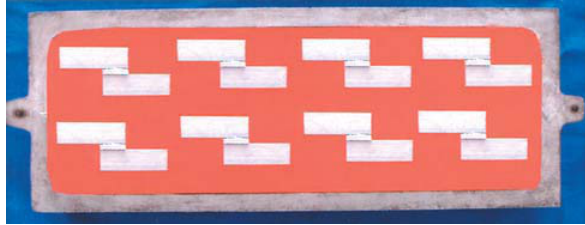
FIGURE 2- Aluminum bars and spacer in the mold used for fabrication of shear strength specimens